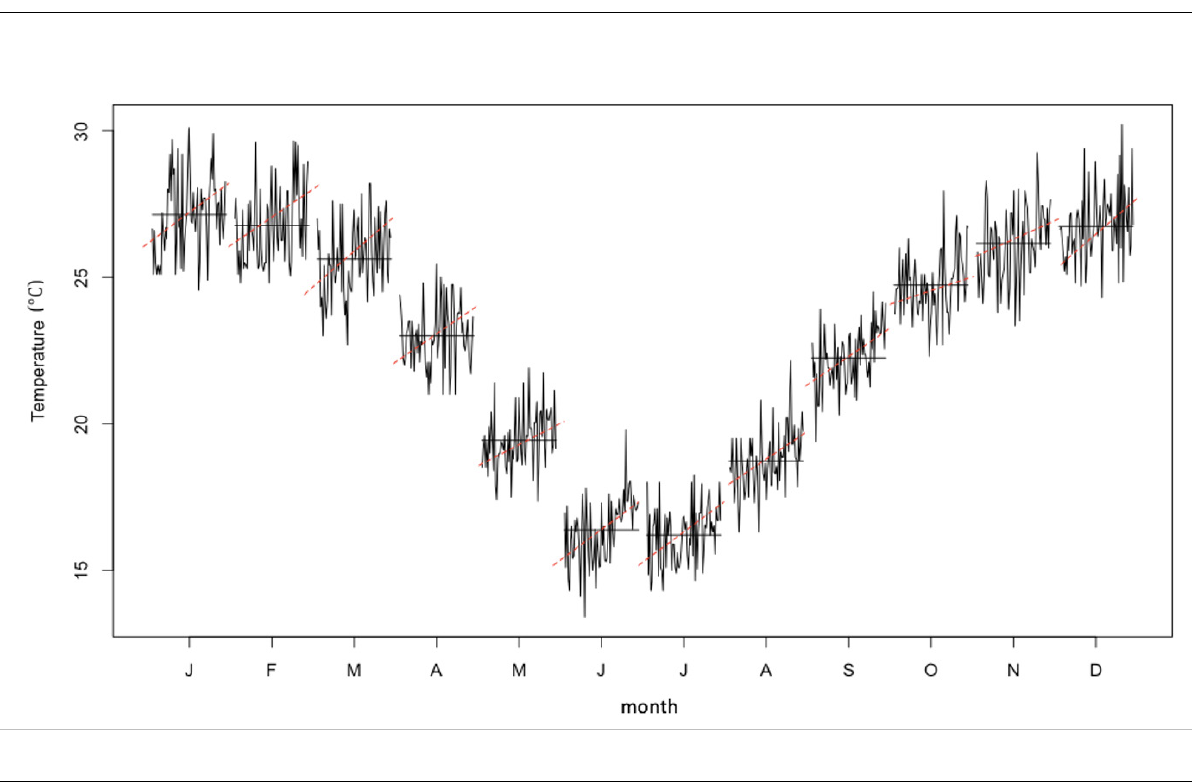
Figure 3: Mean monthly temperatures for northernmost Limpopo Province, 1950–2016. Horizontal lines represent monthly mean values and red dotted lines represent trend